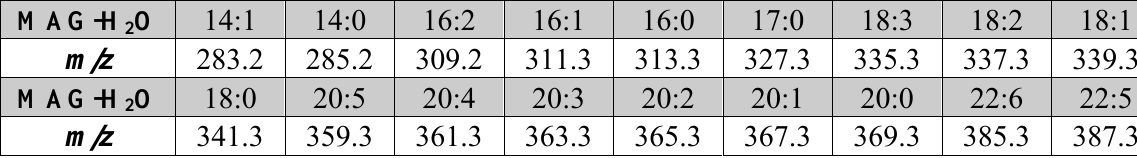
O fragments used for MPIS 2